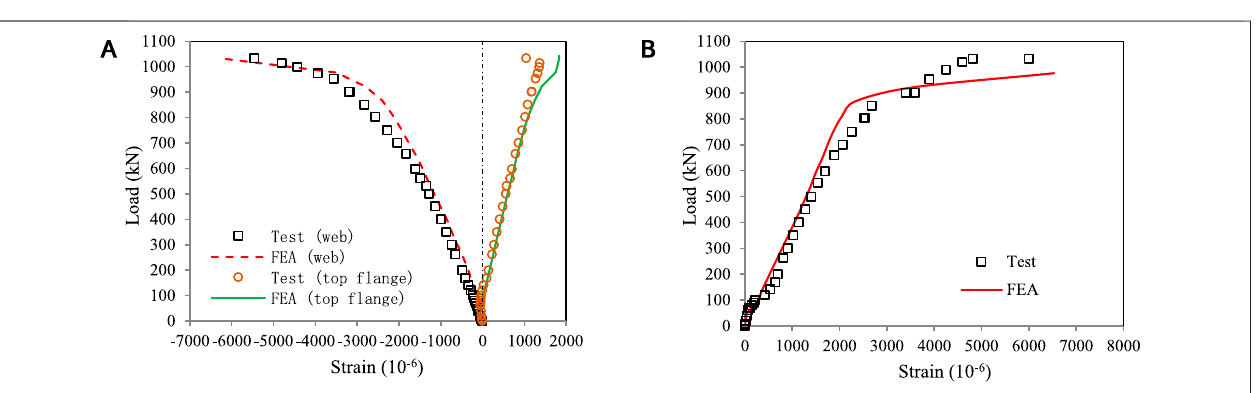
FIGURE 8| Comparison of calculated and tested values ofstrain in the steel beam and the rebar: (A) strain curvesof the steel beam; (B) strain curves ofthe rebar.